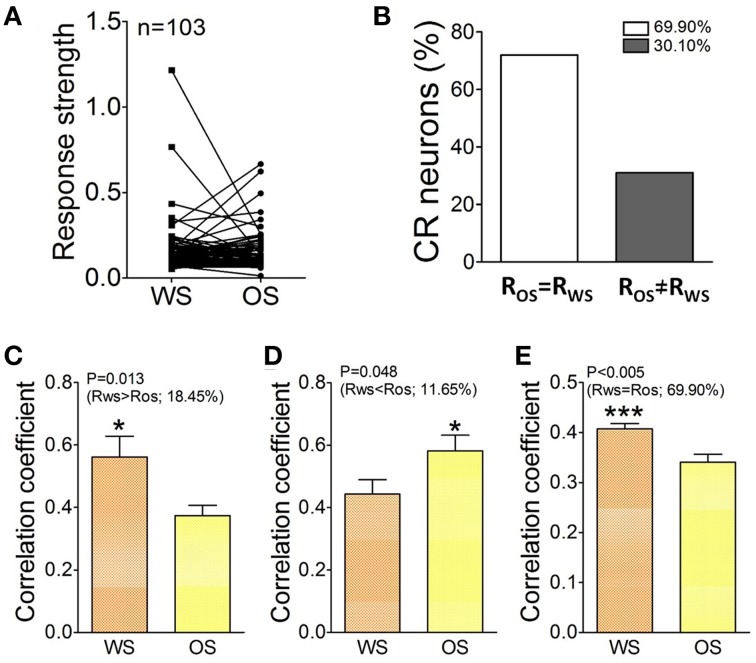
The activity level and cross-correlation of barrel cortical CR neurons in response to OS and WS. (A) Activity levels from CR neurons in response to WS and OS are different (n = 103 neurons). (B) Shows the percentages of CR neurons with equal strength (RWS = ROS, white bar, 69.9%) vs. distinct strength (RWS≠ ROS, gray, 30.1%). (C) Illustrates correlation coefficients for 18.45% CR neurons with RWS > ROS in response to WS (orange bar) and OS (yellow; p = 0.013; paired t-test). (D) Shows correlation coefficients for 11.65% CR neurons with RWS < ROS in response to WS (orange bar) and OS (yellow, p = 0.04; paired t-test). (E) Shows correlation coefficients for 69.9% CR neurons with RWS = ROS in response to WS (orange bar) and OS (yellow, p = 0.005; paired t-test). The recognition of barrel cortical neurons to WS and OS by encoding their different activity synchronies. *p < 0.05; ***p < 0.001.